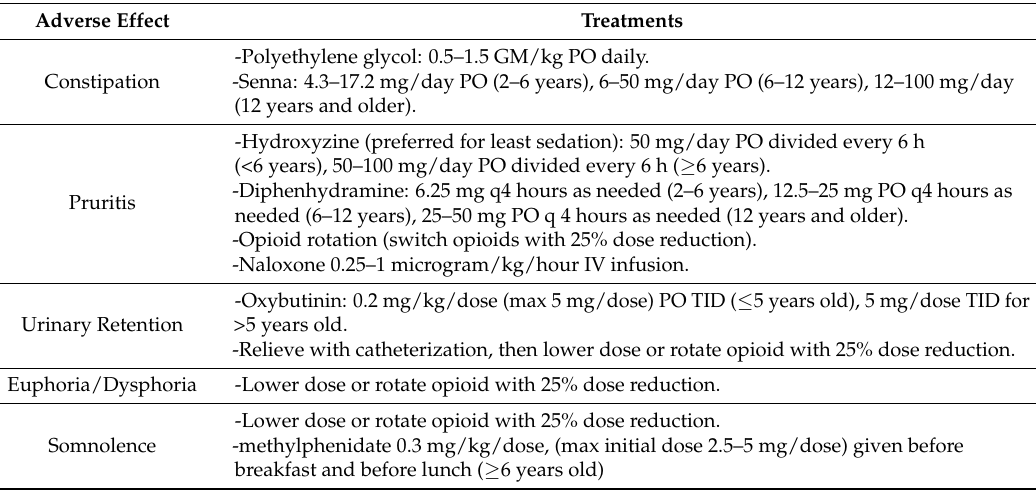
Table 5. Common or important opioid adverse effects and